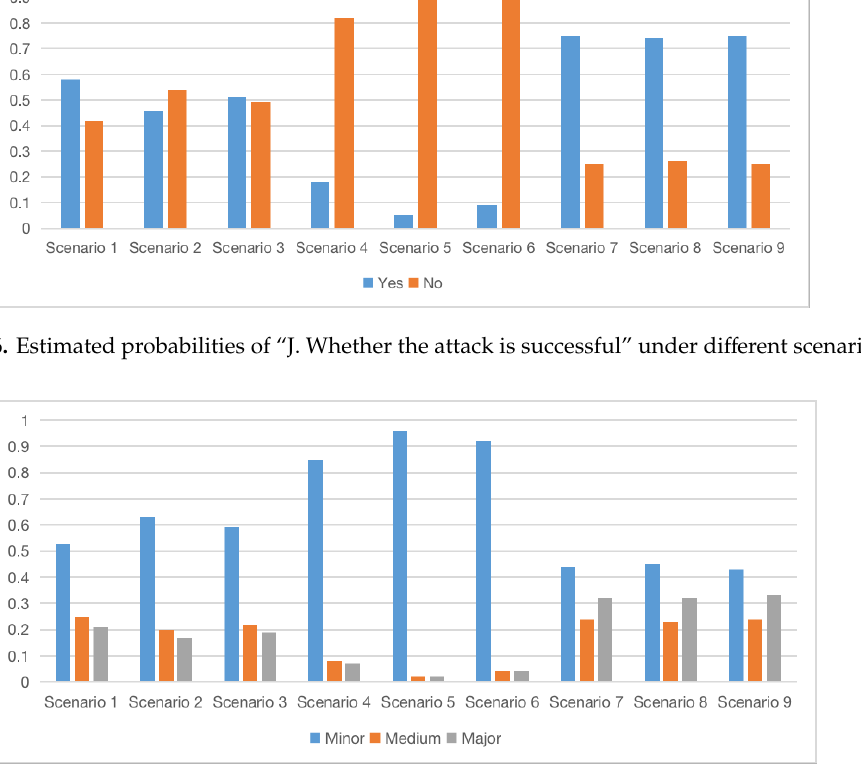
Figure 7. Estimated probabilities of “K. Casualties” under different scenarios.